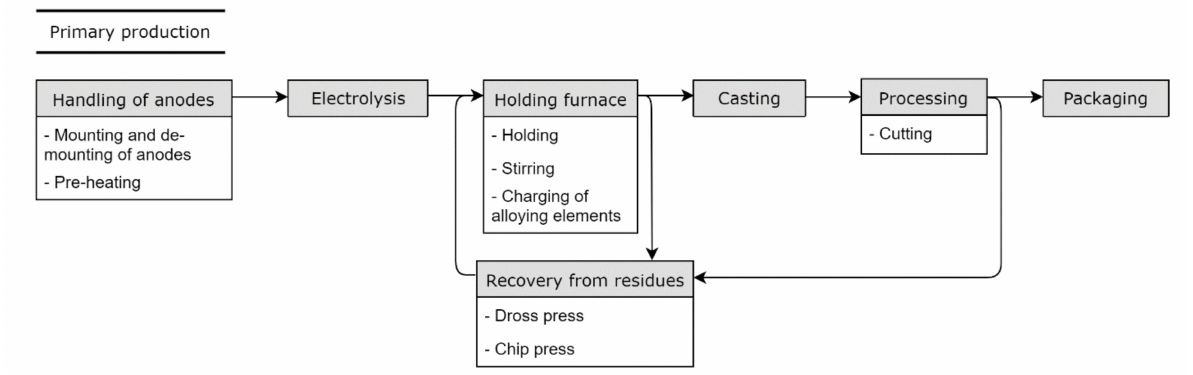
Figure 1. Production processes associated with the primary production of